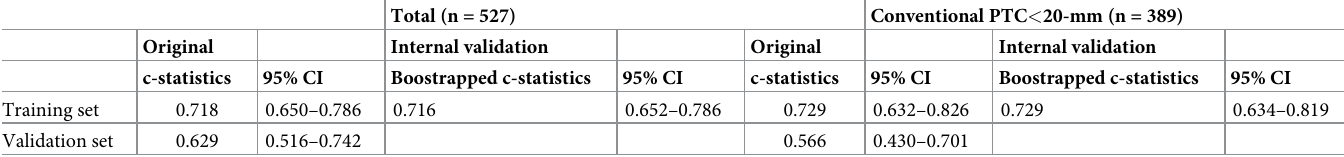
Table 3. Discrimination ability of the models in the total thyroid cancers and the conventional PTCs <